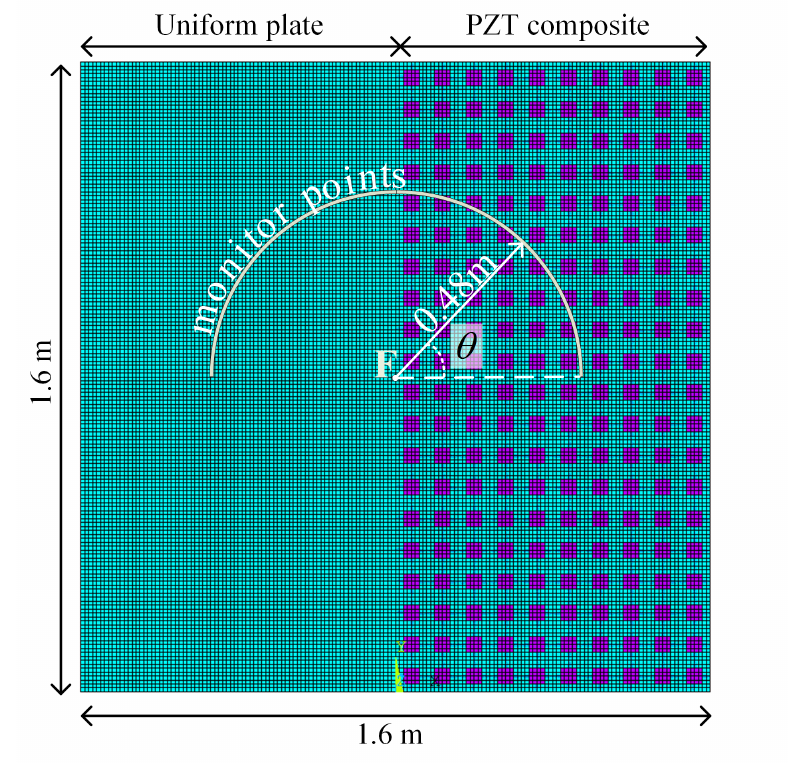
Figure 17. Finite element model used for validation